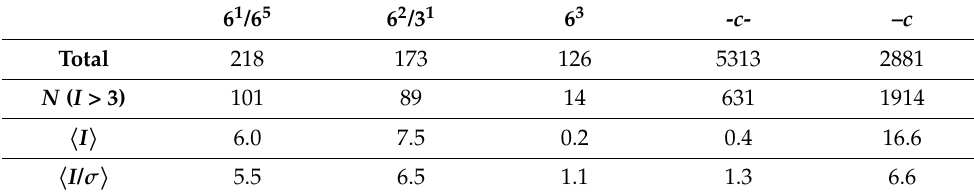
Table 5. Systematic absence exceptions for LT-Cu 3 − x As dataset.